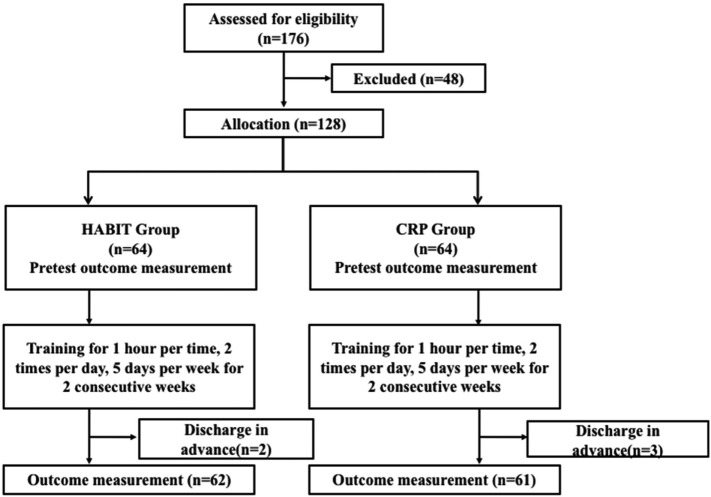
Patient flowchart.